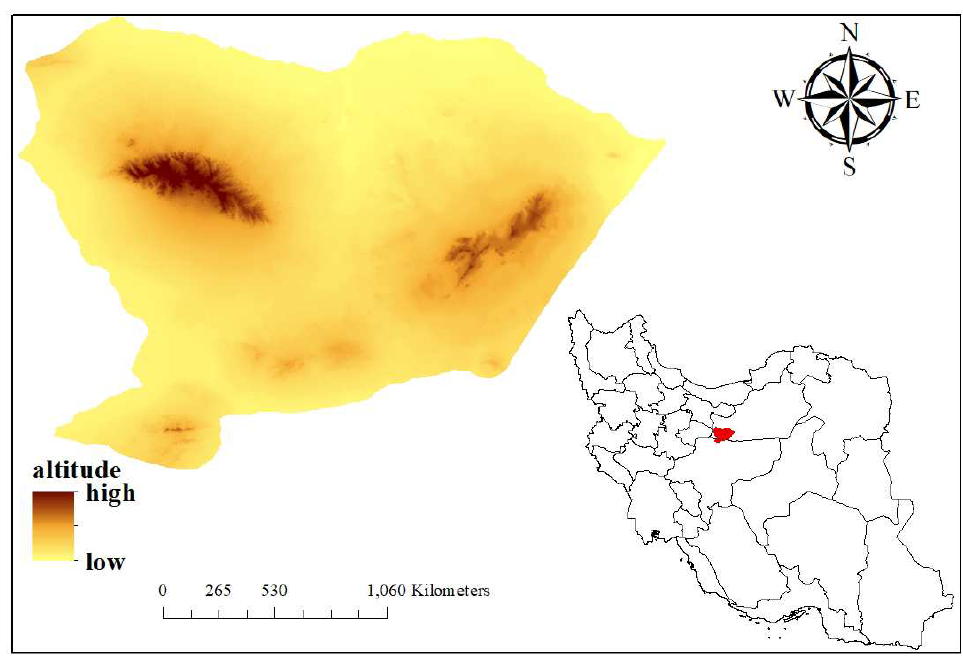
F IGURE 1. The studied area in Kavir National Park, Semnan Province.